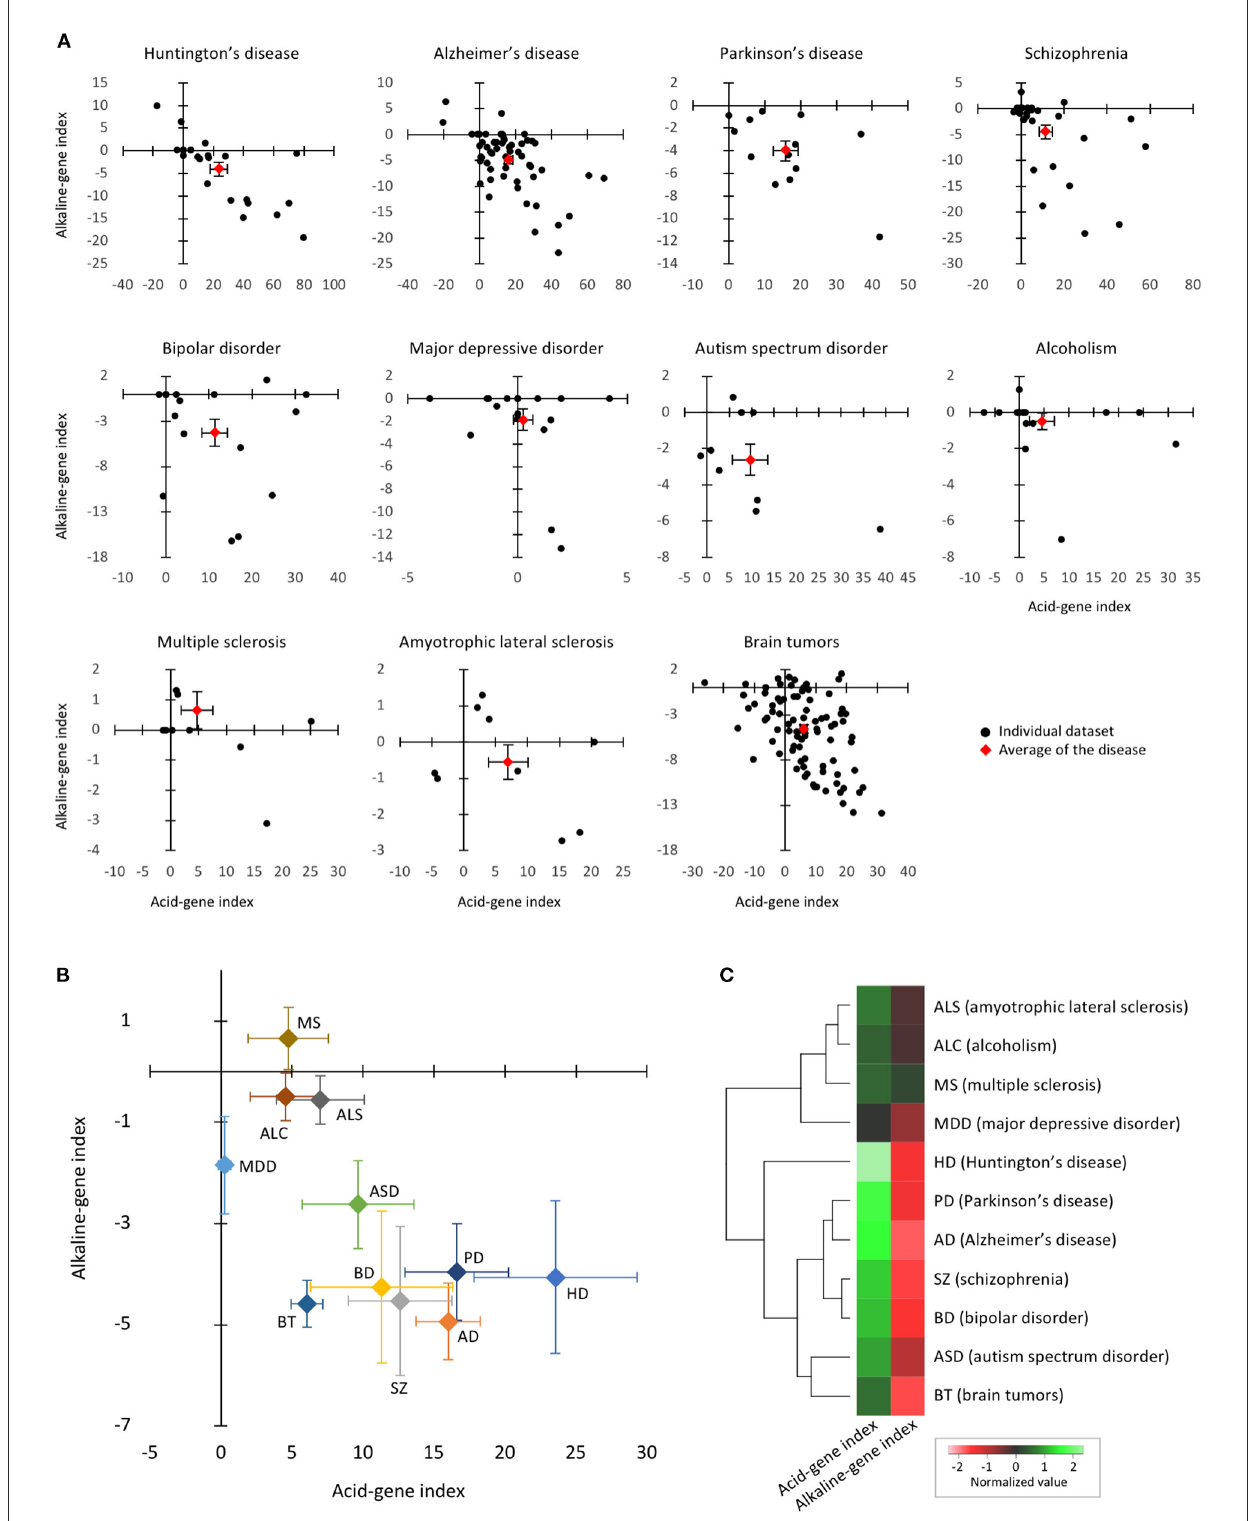
FIGURE3 Expression patterns of pH-associated genes in the brain of neuropsychiatric and neurodegenerative disorders. (A) The two-dimensional plot results of individual datasets within each disease. Black plots indicate individual datasets and red plots indicate the mean of the datasets in the disease. Error bars are standard errors of the mean. (B) The two-dimensional plots of 11 diseases based on the means of the acid-gene and alkaline-gene indices within each disease. Error bars are standard errors of the mean. (C) Hierarchical clustering of 11 diseases based on acid-gene and alkaline-gene